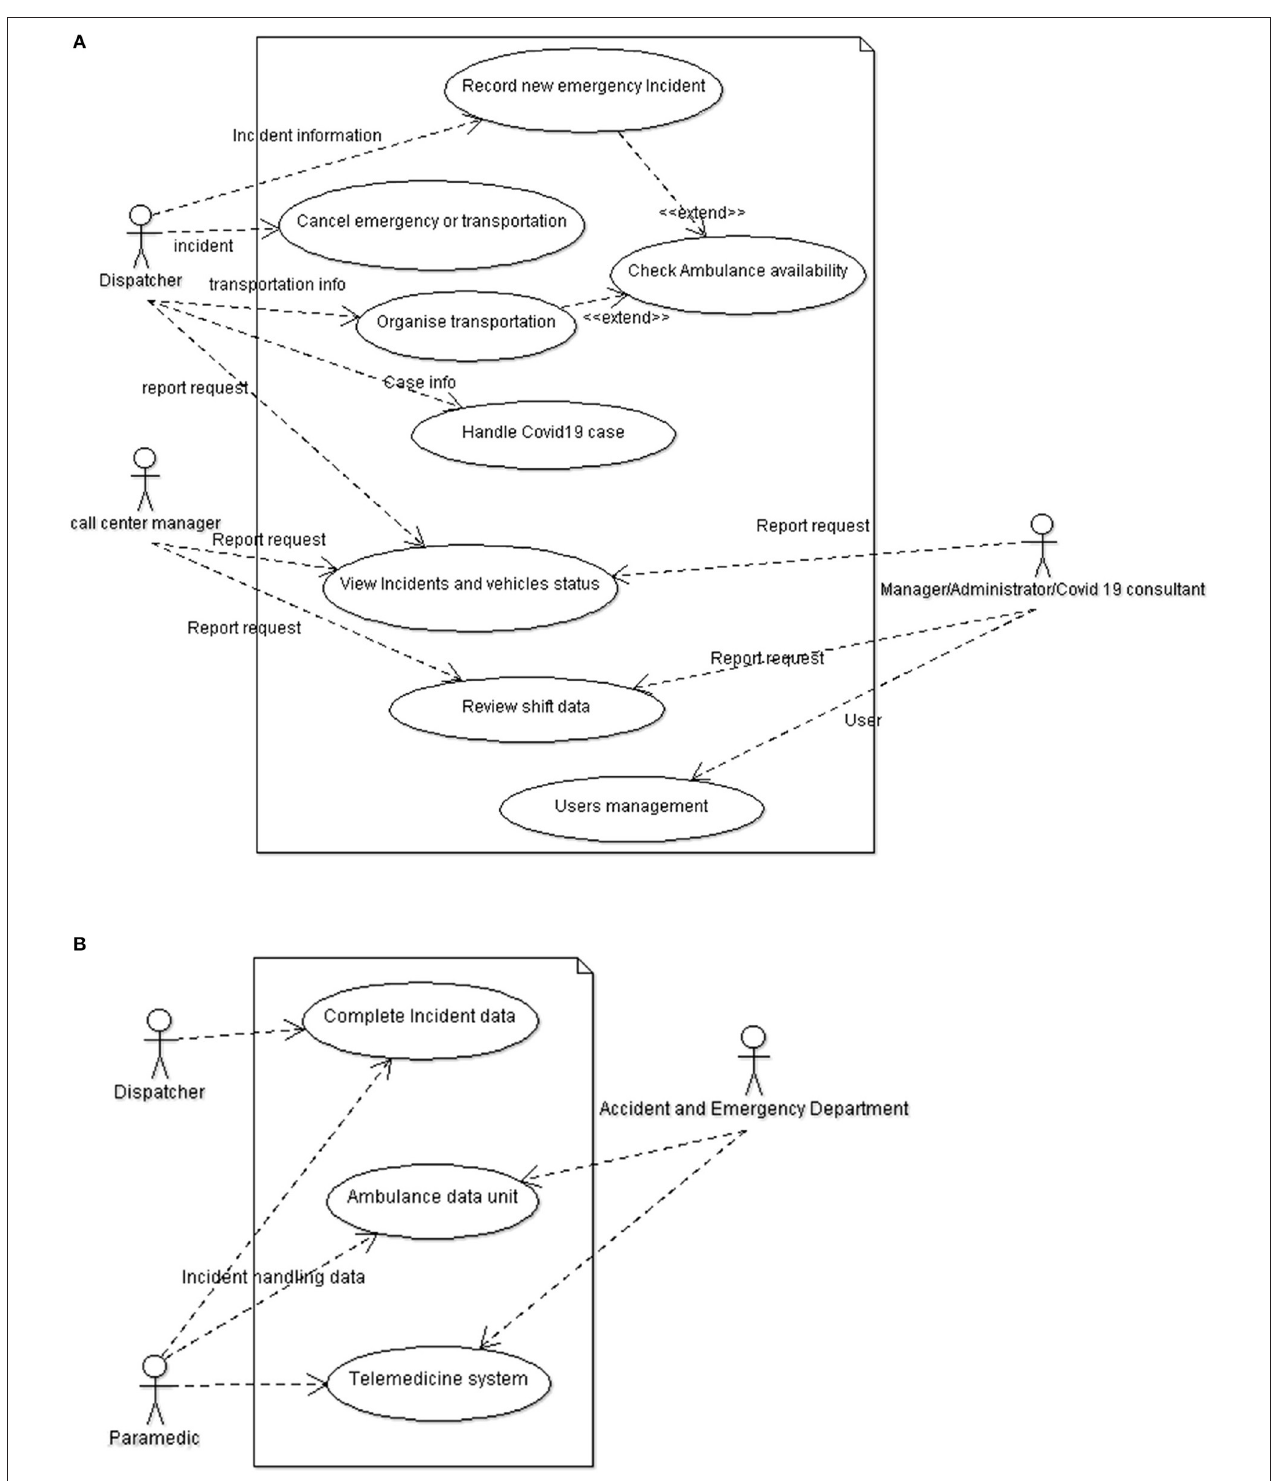
FIGURE 1 | Use case diagram displaying the use cases or functions of users that take place in the system. (A) Part one shows the functions of users within the developed system for emergency call handling and ambulance management prior to the dispatchment of the ambulance. (B) Part two shows the interactions of the Dispatcher, Paramedic, and Accident and Emergency Department unit that includes doctors after the ambulance is dispatched. Through these interactions data is exchanged between call center ( via Dispatchers), the ambulance vehicles ( via Paramedics), and Accident and Emergency Department unit ( via doctors).